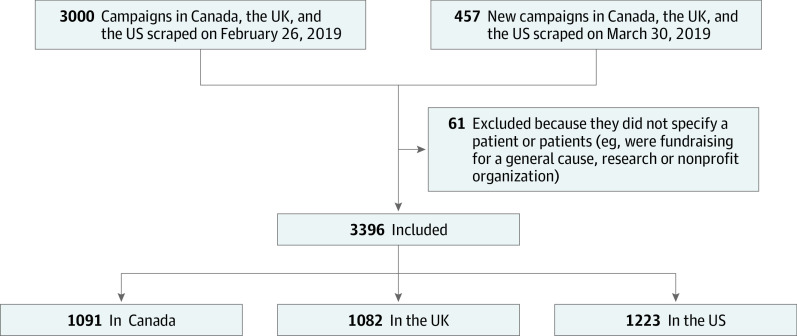
Study Flow Diagram